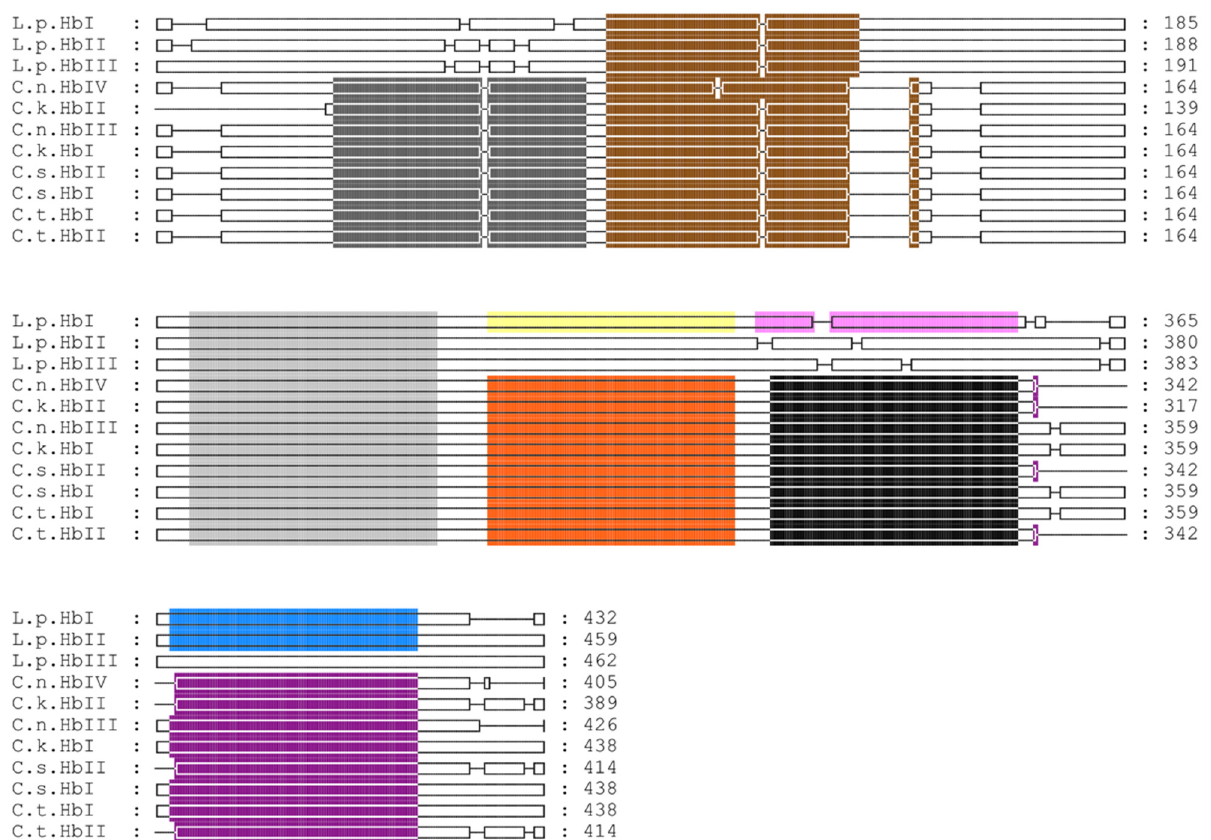
Figure 7 . Multiple sequence alignment of coding regions of hemoglobins from Lucina pectinata and Calyptogena. Multiple sequence alignments were carried out using M-COFFEE, motif analysis was done using MEME and aligned sequences visualized in GeneDoc. The abbreviations are as follows: L.p. ( L. pectinata ), C.n. ( C. nautilei ), C.k. ( C. kaikoi ), C.t. ( C. tsubasa ), C.s. ( C. soyoae ). Detected motifs are represented in different colors.